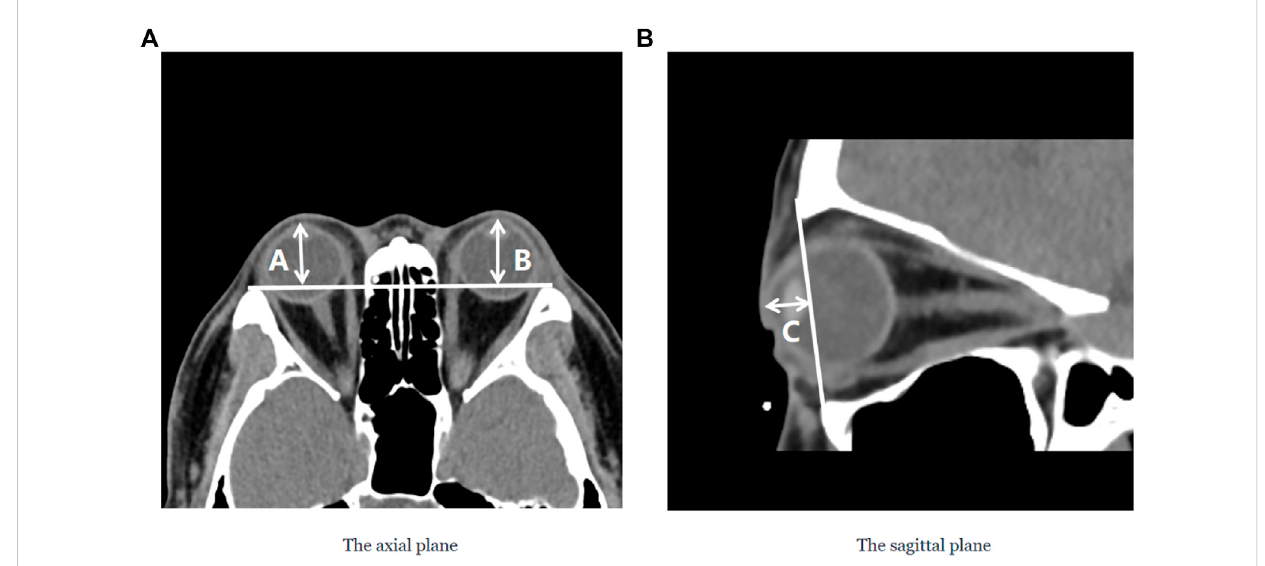
FIGURE 9 TwocommonlyusedclinicalparametersformeasuringtheprominenceoftheeyebasedonCTimages. (A) TheaxialplaneoftheCTimage,(AandB) representtheverticaldistancefromtheapexoftheanteriorcornealsurfacetothelateralorbitalrimofbotheyes,respectively; (B) Thesagittalplaneofthe CT image, C represents the vertical distance from the apex of the anterior corneal surface to the longest line of the upper and lower orbital